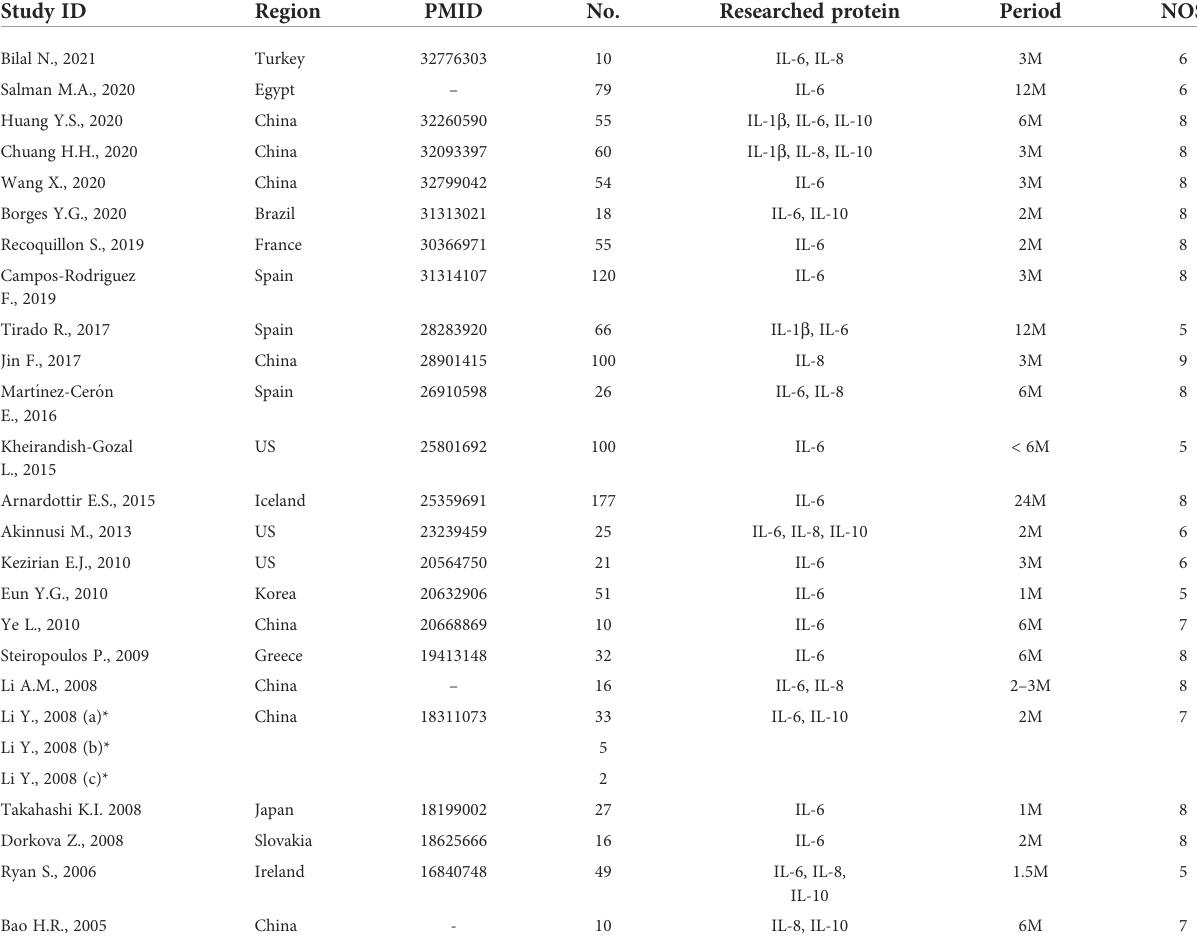
TABLE 2 Characteristics of included studies about interleukin changes during